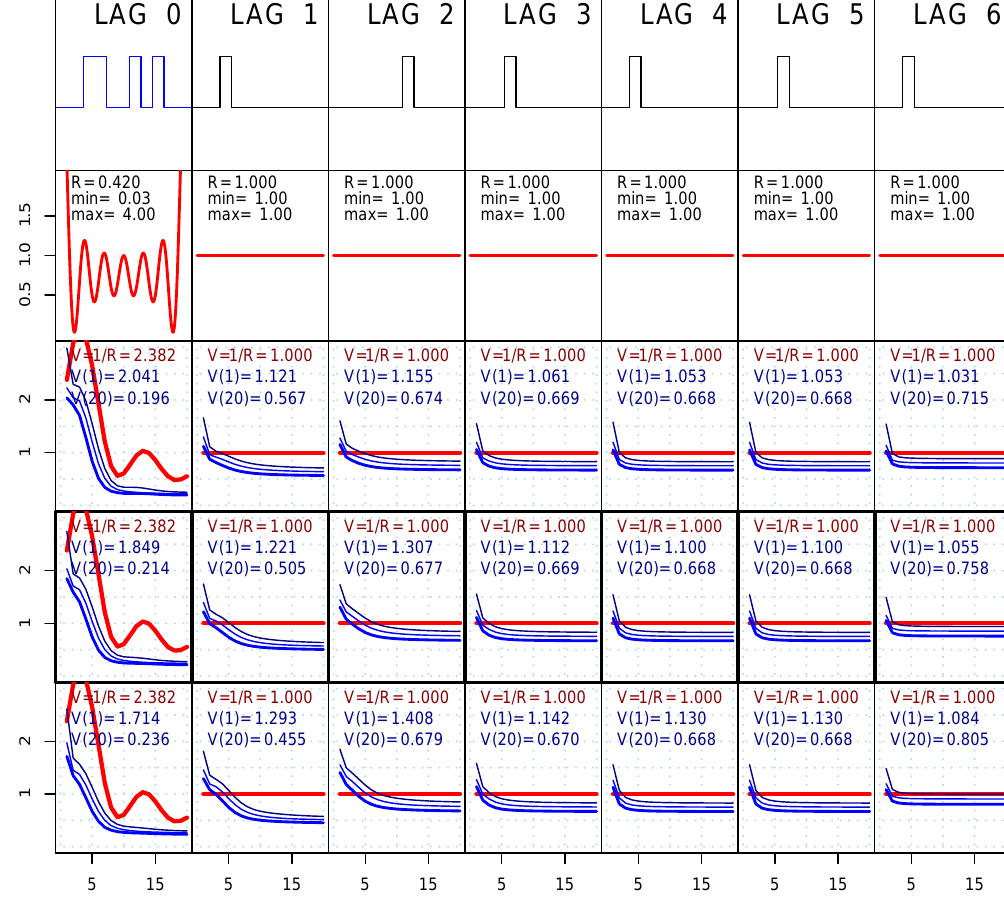
If the ambiguity is a Kronecker delta of unit magnitude, the corresponding Fisher information is a constant one in Fourier side. Thus, a constant one represents a set of codes representing exactly the same kind of information that can be obtained from a single unit-strength pulse pair. A con- stant unit value here represents a perfect code set in the sense that the statistical properties of the analysis result are exactly equal to those corresponding to a simple pulse pair. However, we have normalized this curve by dividing it by the length of the ambiguity function – so it actually means that a constant unit value means pulse compression perfectly done with a apparent power corresponding to the length of the ambiguity function. Please, note that the frequency axis is that of the FFT soft- ware: zero frequency corresponds to the left side of the figure while small negative frequencies are found on the right side of the x-axis. The center of the x-axis corresponds to the highest frequencies seen with the time discretization